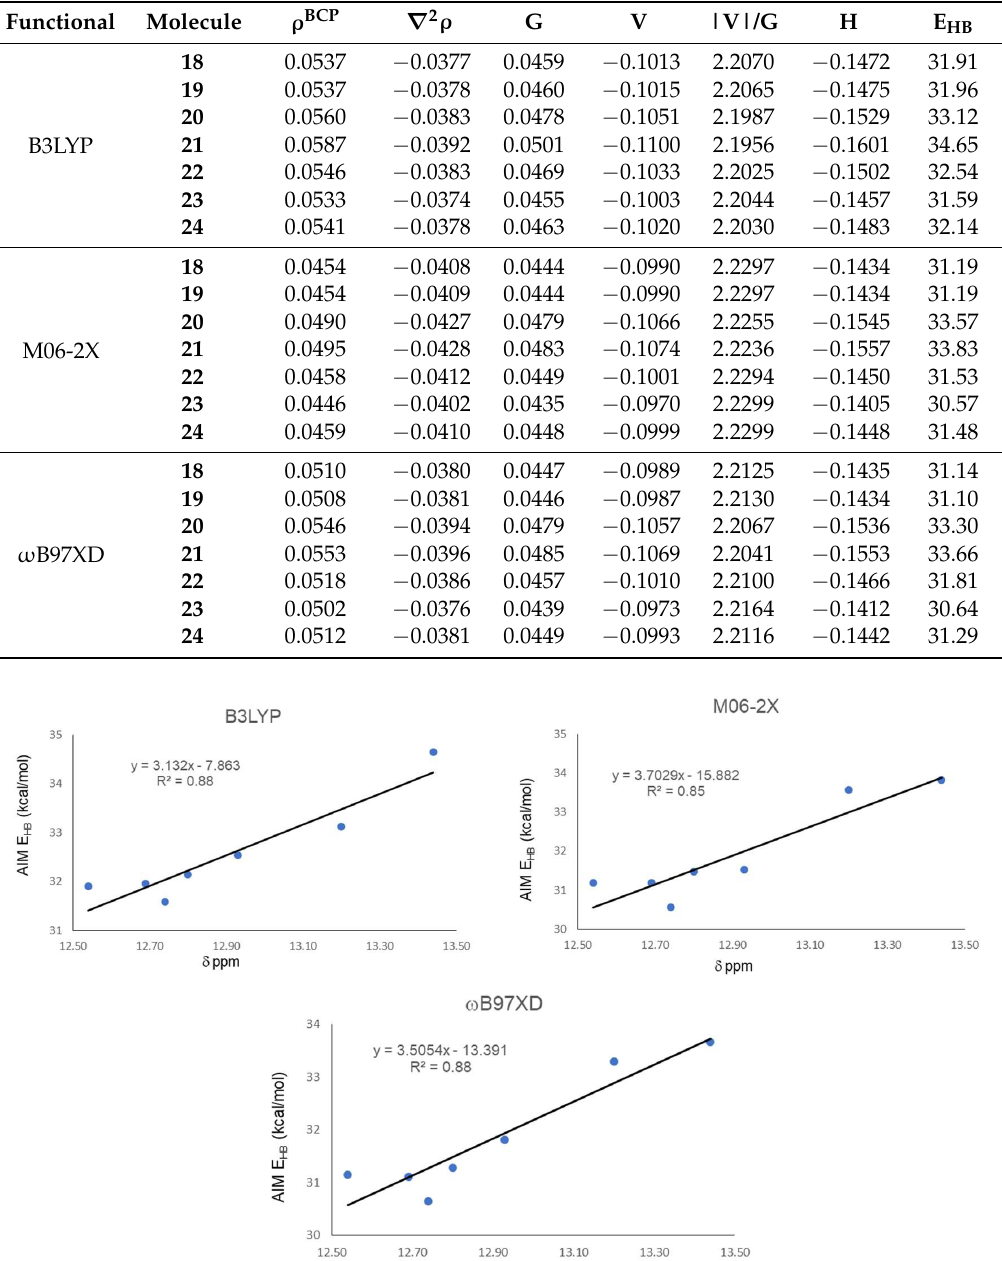
Figure 4. Correlations between hydrogen bond energy E HB (kcal/mol) and experimental chemical shifts δ (ppm) of proton involved in IMHB.